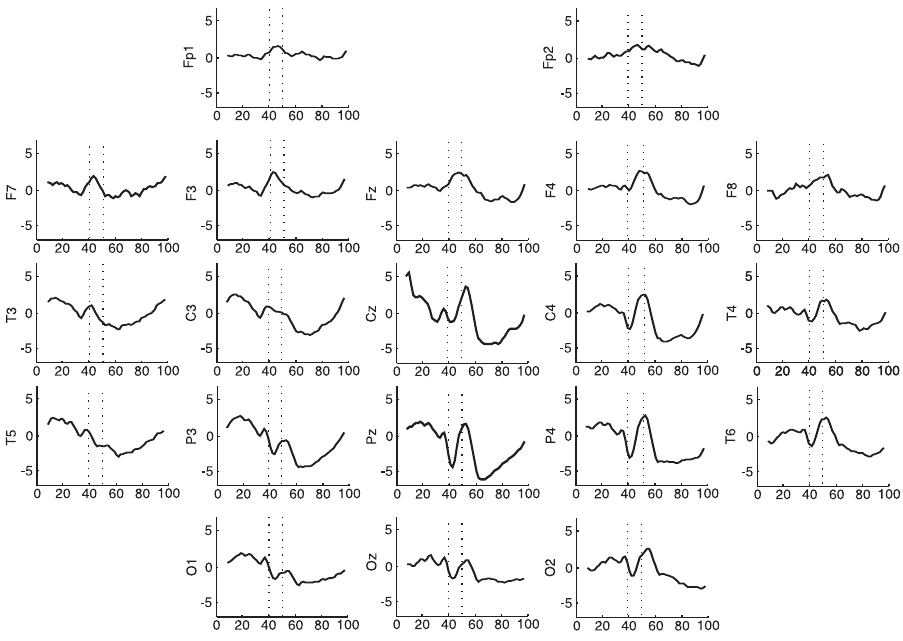
Figure 3. Somatosensory evoked potential topography of volunteer #1 stimulated at 23 mA. Time scale (abscissa) in ms and amplitude scale (ordinate) in µV. Vertical dotted lines indicate 40 and 50 ms,